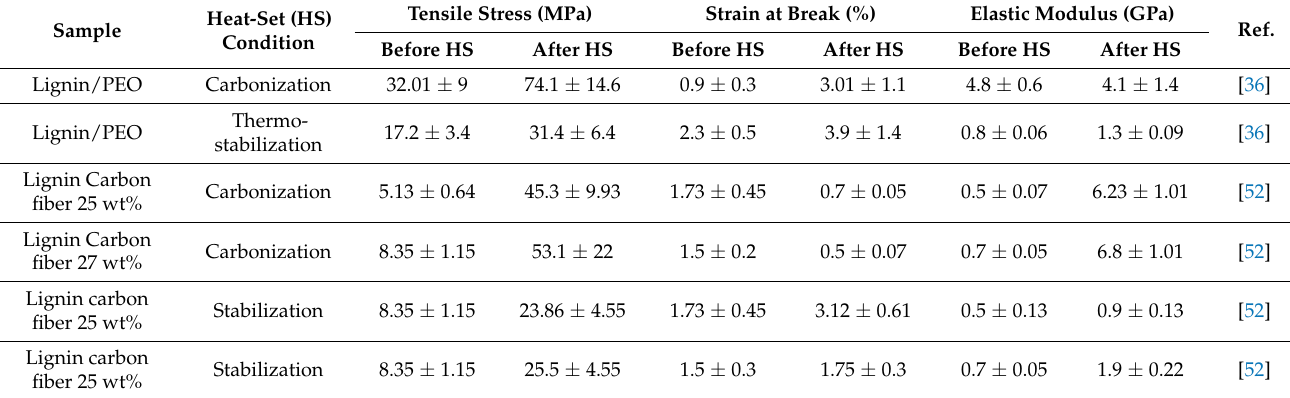
Table 3. Comparision of the tensile stress, strain at break, and elastic modulus properties of different blended lignin electrospun products from past investigations, depending on the heat-set conditions.